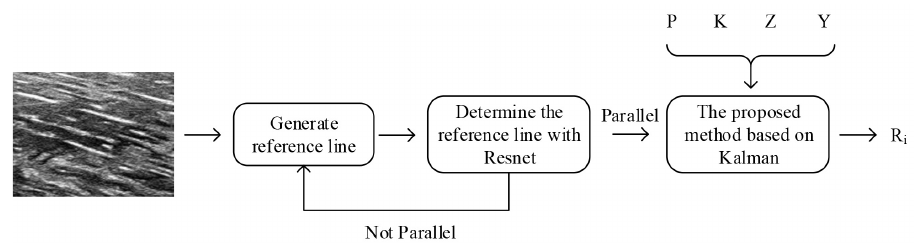
Figure 3. Algorithm framework of our proposed method.